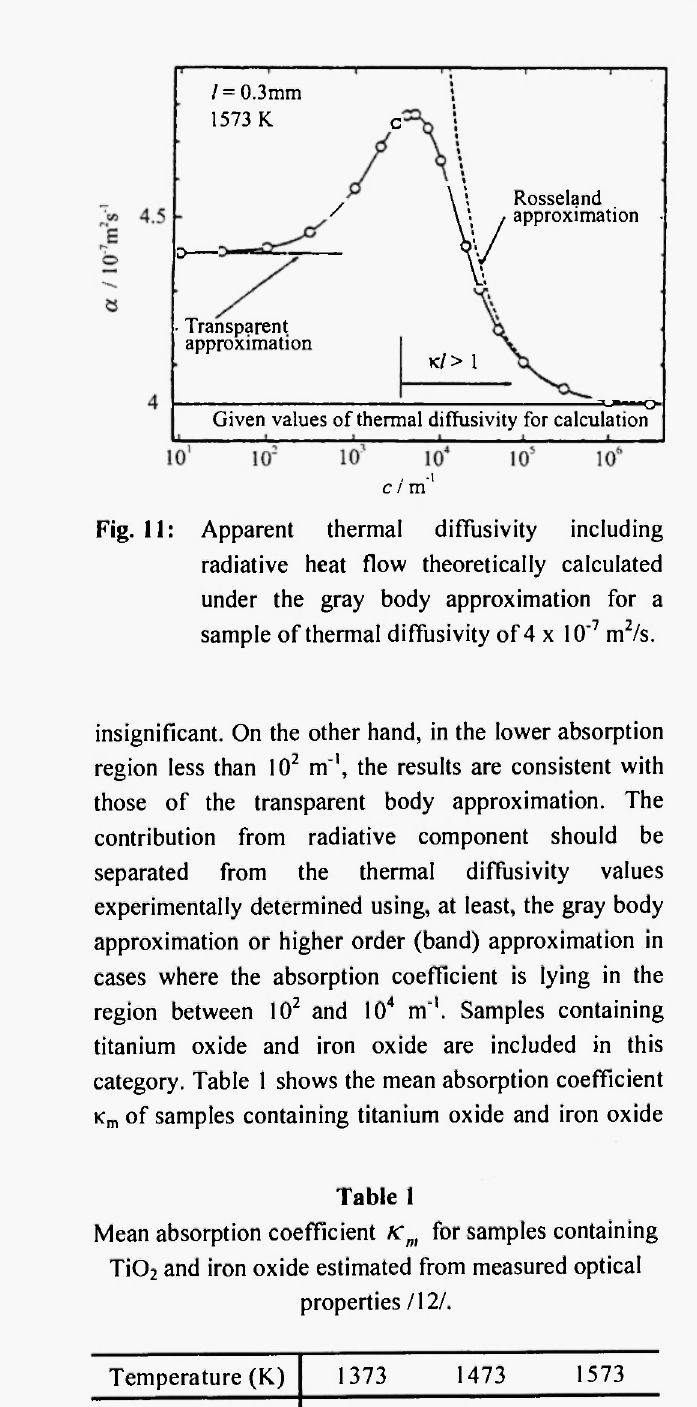
layered laser flash method. Given thermal diffusivity: 4 χ 10" 7 m 2 /s, sample thickness and its variation: 0.2 mm Mean absorption coefficient K m for samples containing and 0.2 mm. The numerical values in the parenthesis Ti0 2 and iron oxide estimated from measured optical correspond to the ratio of deviation from the case properties /12/. estimated under the band approximation